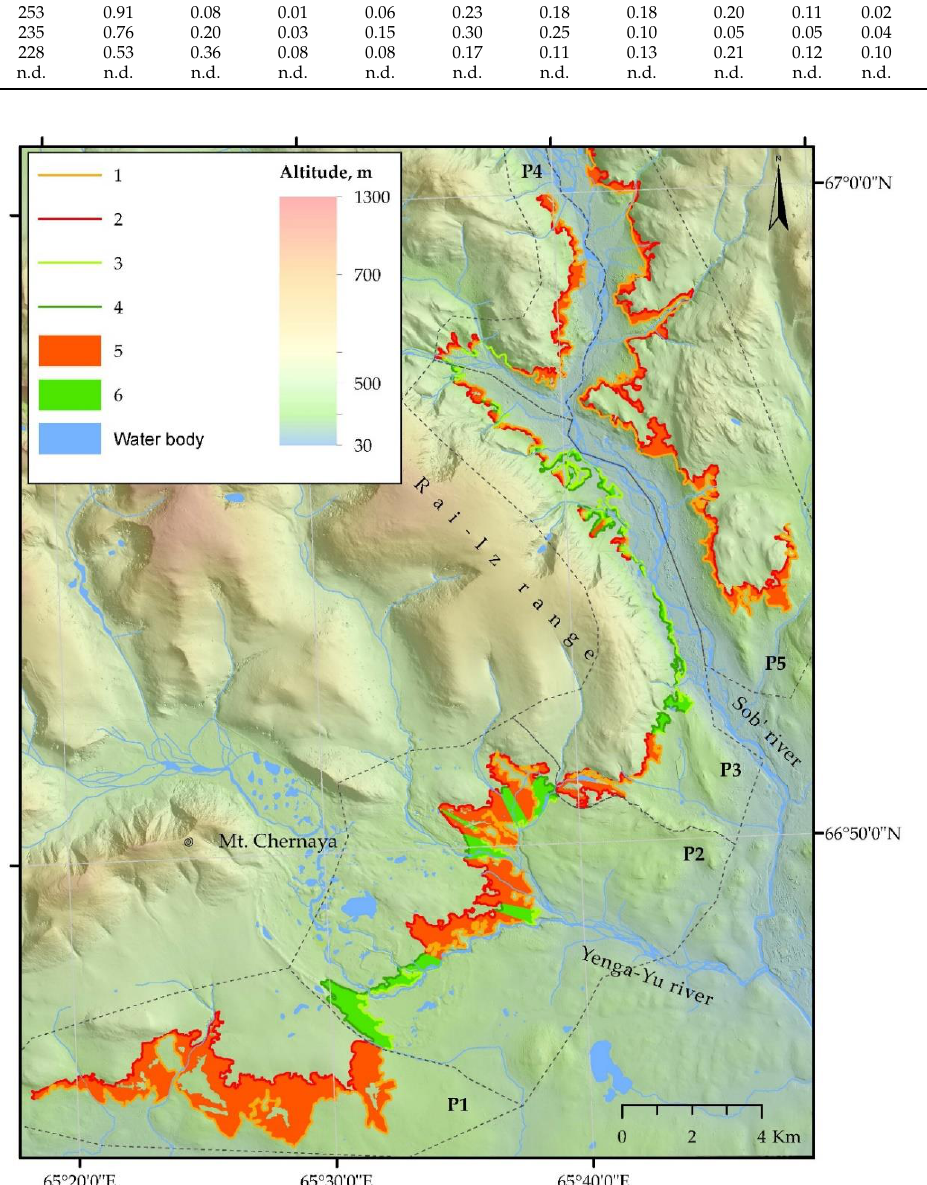
Figure 9. Position of upper open forest boundary in 1960 (1 and 3) and 2020 (2 and 4) at different parts (P1 – P5) of the studied subregion of Polar Urals and area occupied by open and closed forests (5 and 6) over the 60-year period (1, 2, 5 — on slopes without wide spread of moraine or river sediment deposits and boulder fields; 3, 4, 6 — on slopes with wide spread of moraine or river sediment deposits and boulder fields). An analysis of the tree stand dynamics over the 60-year period in the studied subregion of the Polar Urals showed that there was an upward shift in the upper boundary of the open forest (closure of 0.1 – 0.2) by an average of 33 m in altitude at slopes without waterlogged soils, moraine deposits or boulder fields (see Figure 9) and 9 m at slopes with a prevalence of them. Minimal values (0 – 11 m) were noted at the slopes with edaphic constrains on parts three and four (see Figure 9 and Table 6), whereas the maximum value (42 m) was marked in part one. A comparison of the mean altitude of the upper op en forest boundaries on the slopes with different expositions within the Sob’s river valley (parts # 3 – 4 and 5) showed that open forests ascended higher on 33 m on SW – W than on NE – E slopes (Table 7). In general, the area occupied by open and closed forests increased in approximately 27.4 km 2 in this subregion of the Polar Urals over the 60-year period.